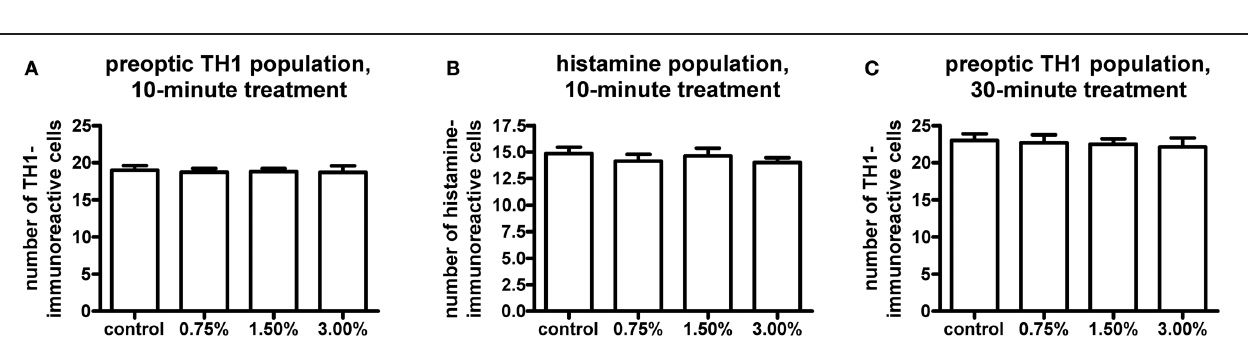
The longer treatment also did not show any changes in cell numbers. Statistical analysis was done using One-Way ANOVA. (A) F ( 3 , 52 ) = 0 . 05260, p = 0 . 9839; (B) F ( 3 , 52 ) = 0 . 4550, p = 0 . 7149; (C) F ( 3 , 33 ) = 0 . 1273, p = 0 . 9432. N = 13–15 for the 10-min treatment, N = 8–10 for the 30-min